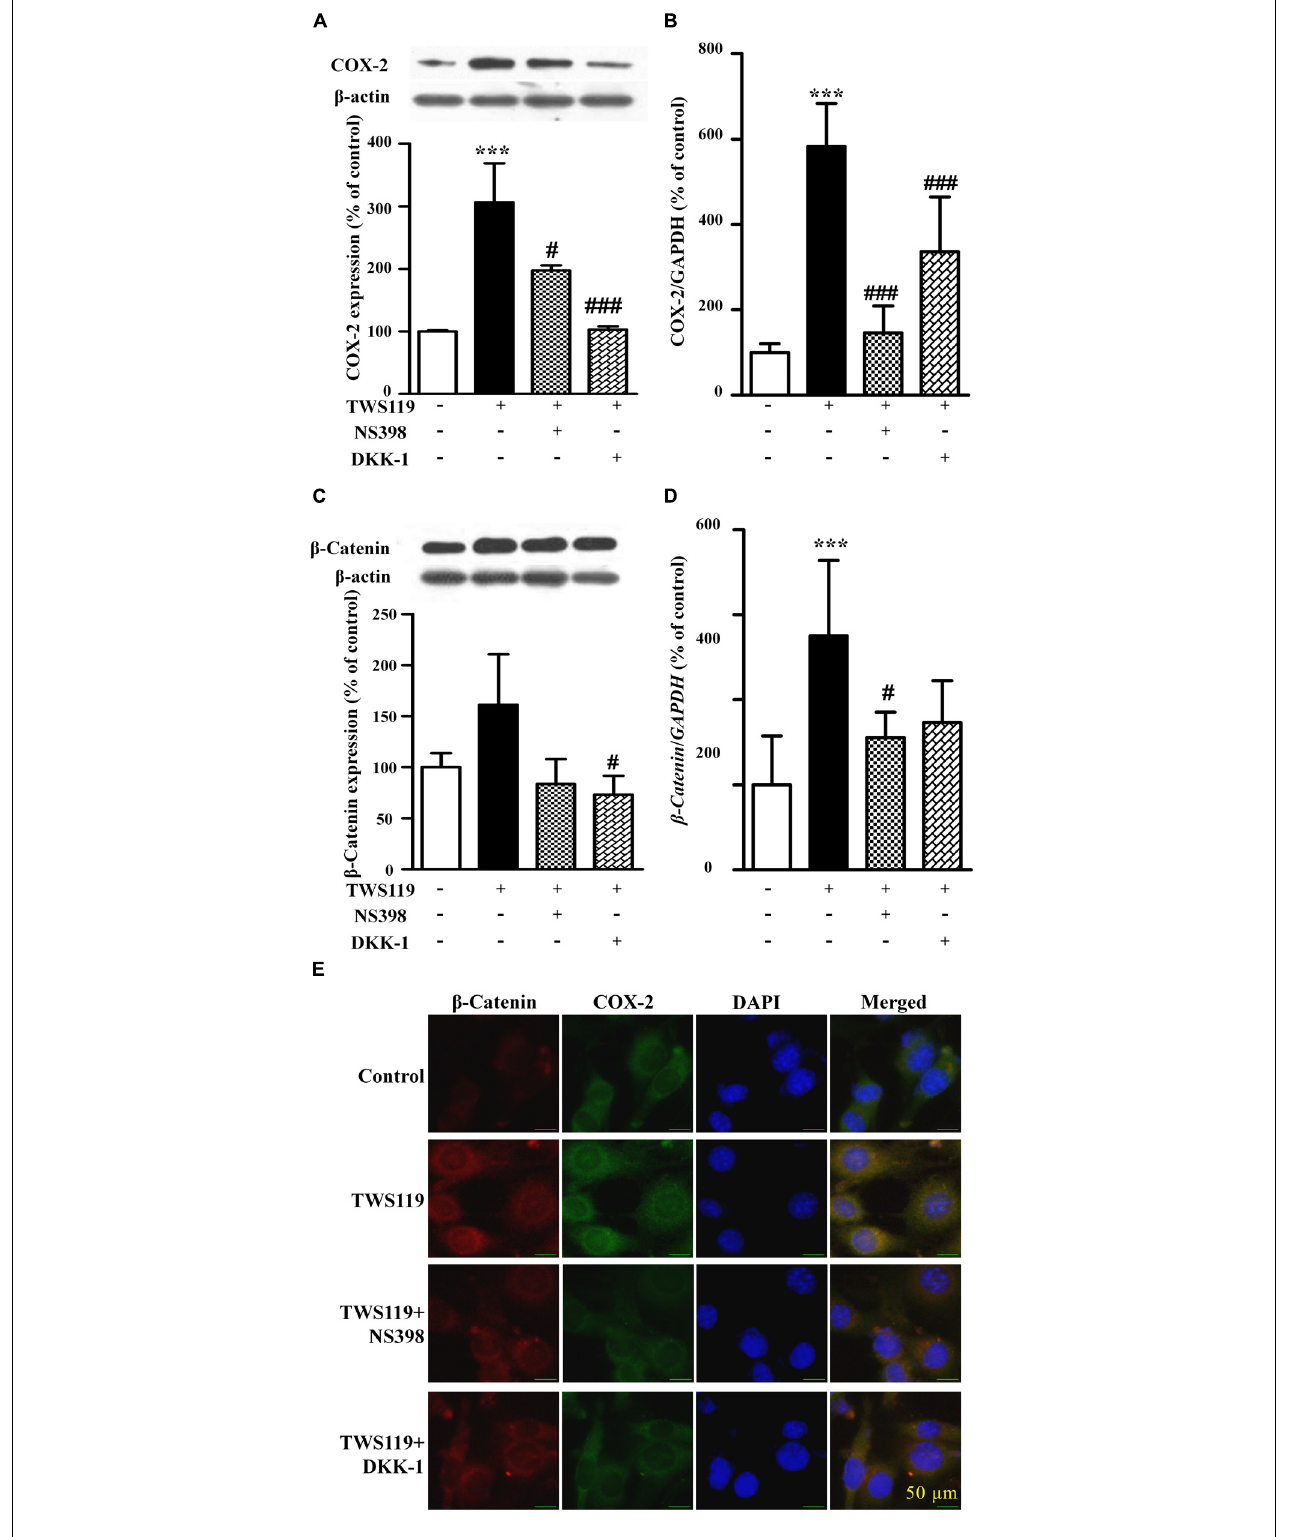
FIGURE 5 | The protein expression and mRNA levels of β -catenin and COX-2 in the NIH3T3 cells treated with TWS119. The protein expression and mRNA quantitative analysis of COX-2 (A,B) or β -catenin (C,D) in NIH3T3 cells. ∗ P < 0.05, ∗∗ P < 0.01, and ∗∗∗ P < 0.001 vs. control; # P < 0.05 and ### P < 0.001 vs. the LPS group, n = 3. (E) The immunofluorescence staining of β -catenin and COX-2 in the NIH3T3 cells. Scale bars: 50 µ m.